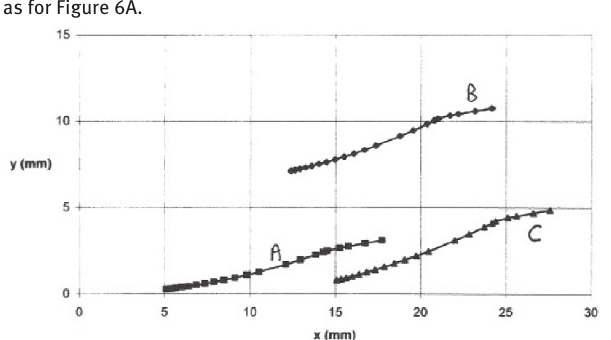
Figure 8B: Showing the trajectories of the transfusion set for the TN- point (curve A), the paths of the G-points with l g = 10 mm, β = 40 ◦ (curve B) and l g = 10 mm, β = 0 ◦ (curve C). All other parameters same as for Figure 5A.